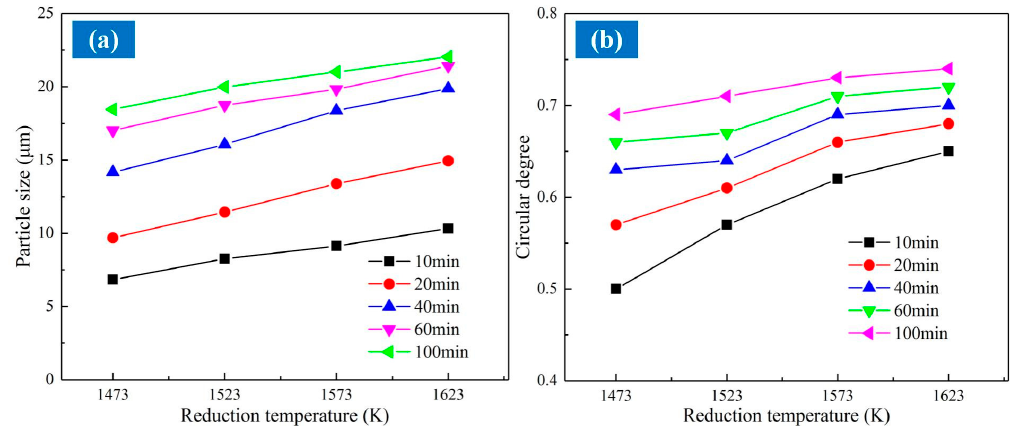
Figure 10. Representative grain size parameters of coal-based reduction products. ( a ) The average equal-area circle diameter of particle; ( b ) The average roundness of particle.